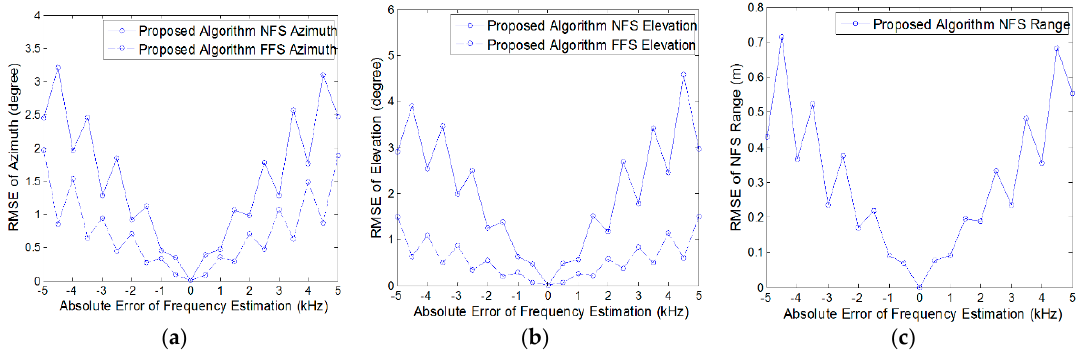
( b ) ( c ) Figure 7. RMSEs versus SNR: ( a ) Azimuth angle; ( b ) Elevation angle; ( c ) Near-field source range. As for the computational cost, compared with the TSMUSIC algorithm with step size = 0.01° for angle estimation and step size = 0.01 m for range estimation, due to the fact that TSMUSIC algorithm requires an expensive search process, the elapsed CPU time for a single run of our proposed method and TSMUSIC algorithm are measured as 0.26 s and 50.95 s, respectively. It is noteworthy that the proposed method has lower computational complexity. 4.3. Performance of Location under Frequency Estimation Error In this section, considering that the frequency calculated by FFT algorithm may not correspond to the frequency of the source. The RMSEs obtained from 500 independent Monte Carlo simulations are employed to show the effect of frequency estimation error. When the SNR is set at 20 dB, we assume that the error between the estimated frequency and the actual frequency is a priori information, the RMSEs of the azimuth angle, elevation angle and the near-field source’s range are given in Figure 8, where the solid curves in blue color represent the RMSEs of the near-field source and the dashed curves in blue color represent the RMSEs of the far-